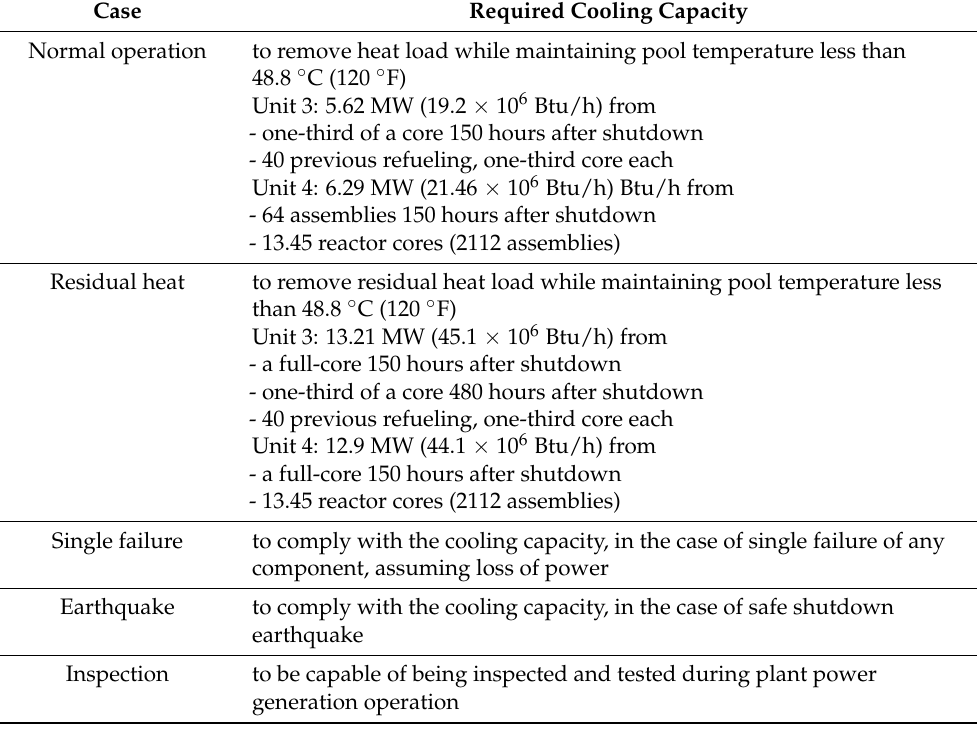
Table 1. System design basis of